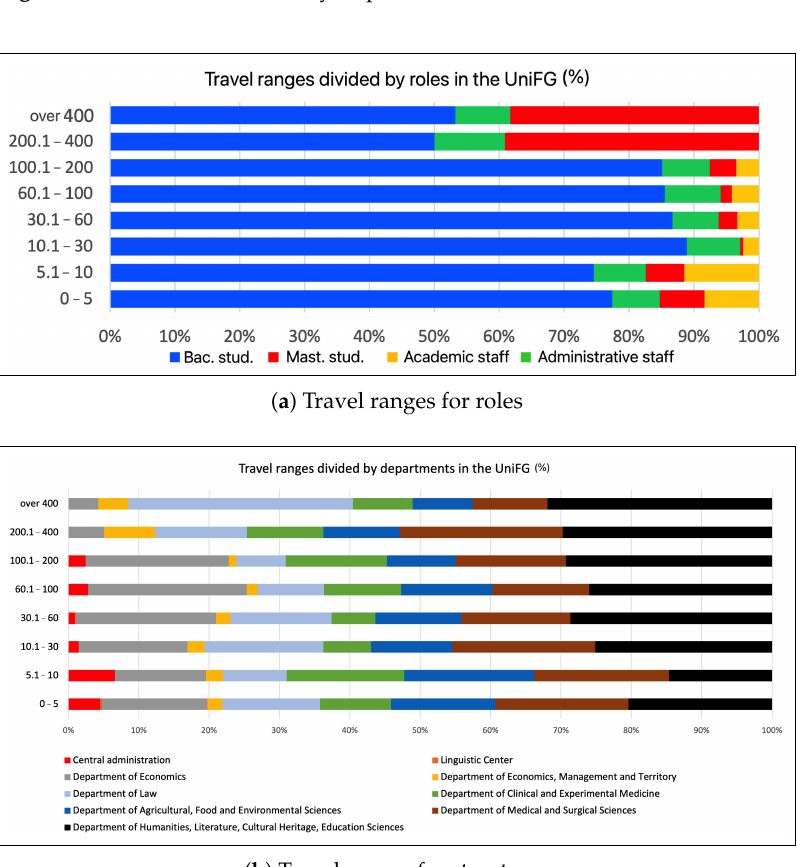
Figure 10. Kilometers traveled by respondents.